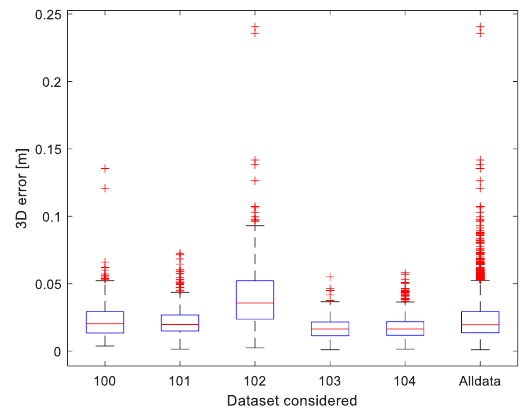
Figure 6 . Box plot of the 3D error for individual points and for the whole dataset.